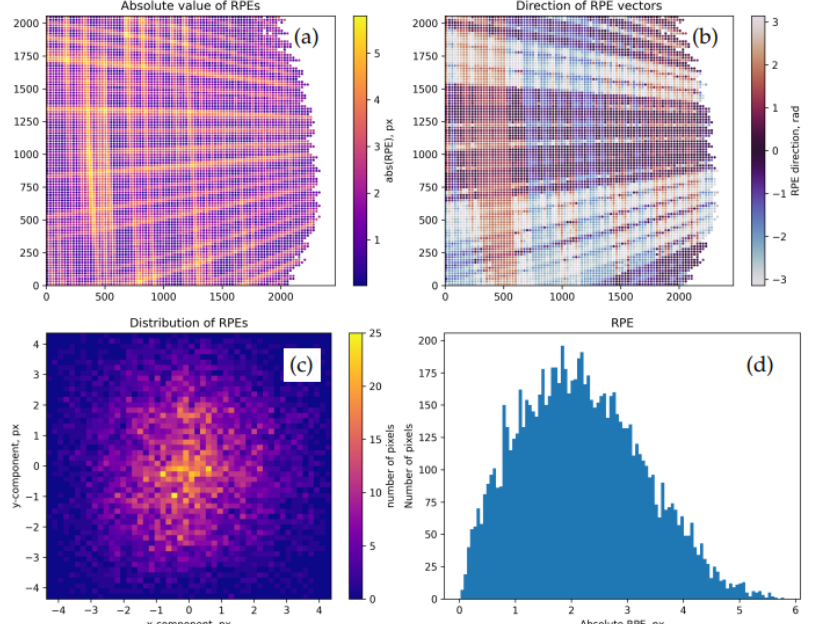
Figure 4. Residual point-wise RPEs for the model A calibrated over the dataset 0, pose 13. The values are shown at sub-sampled pixels. ( a ): D RPE mapped over the sensor. The visible low-frequency Moiré structure results from the interference between the pixel grids of the camera and the screen. (cid:16) (cid:17) ( (cid:126) D ) y / ( (cid:126) D ) x ( b ): direction angles tan − 1 . RPEs here demonstrate significant correlations RPE RPE